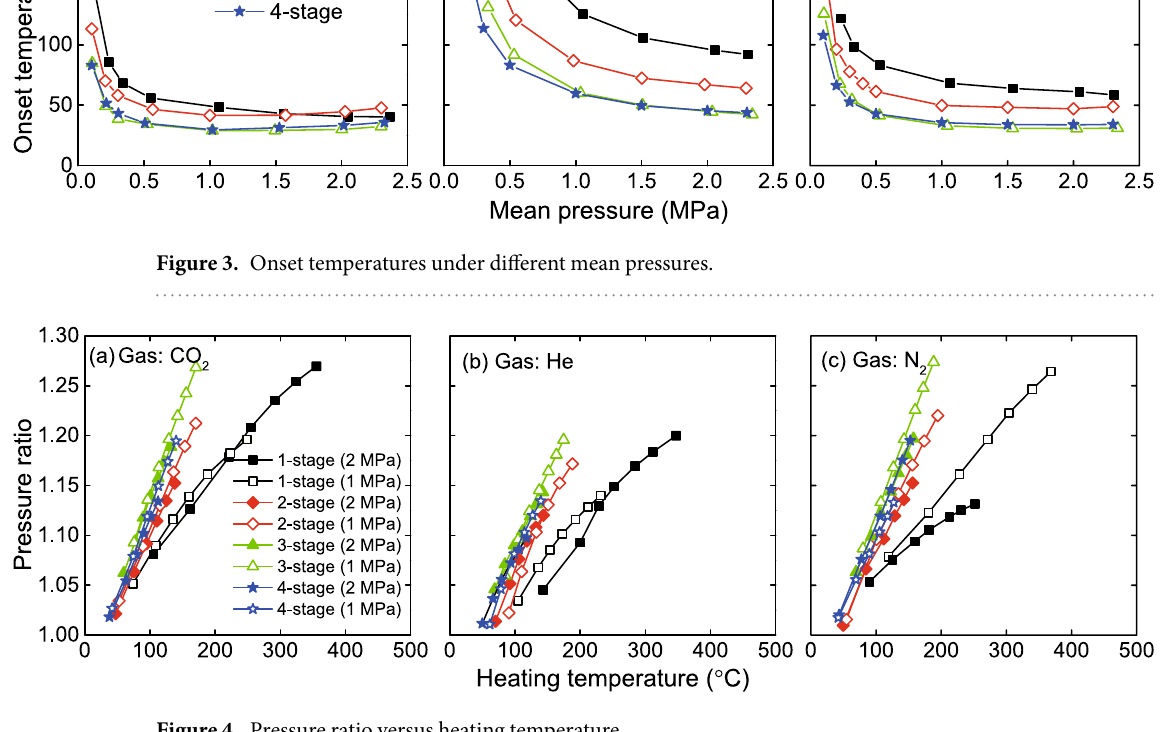
Figure 4. Pressure ratio versus heating